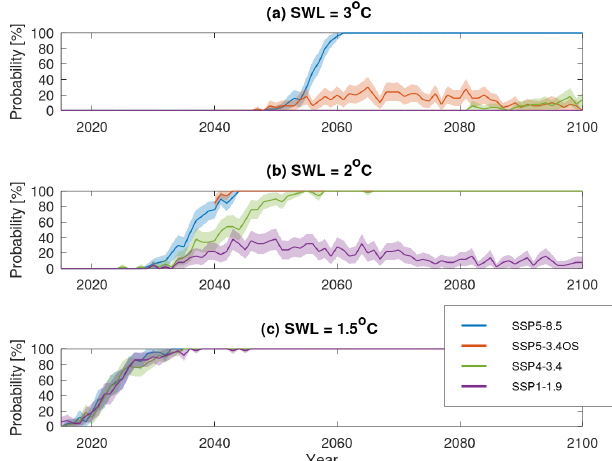
Figure 6. Probability for exceeding a given surface warming level (SWL) in the different scenarios. The SSP5-3.4OS experiment branches off from SSP5-8.5 in 2040 according to the CMIP6 ex- perimental protocol, and thus there are no data for this scenario be- fore 2040. The shaded area denotes the 95% confidence interval obtained from bootstrapping with 1000